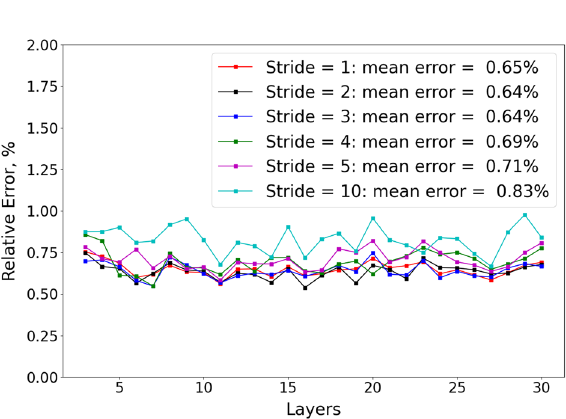
Figure 7. Pressure relative error with time under different strides based on the testing cases.